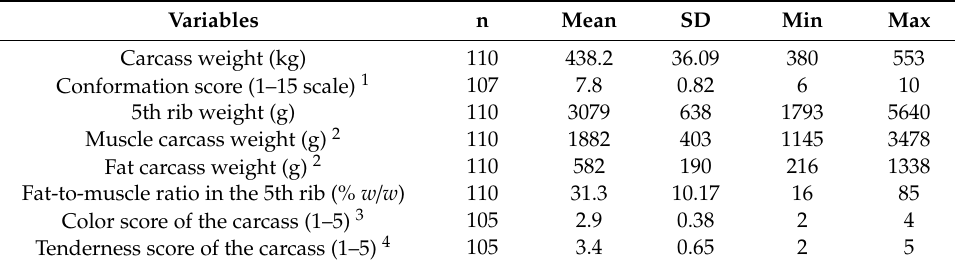
Table 2. Average values and variations of the data from the slaughterhouse level describing the eight carcass